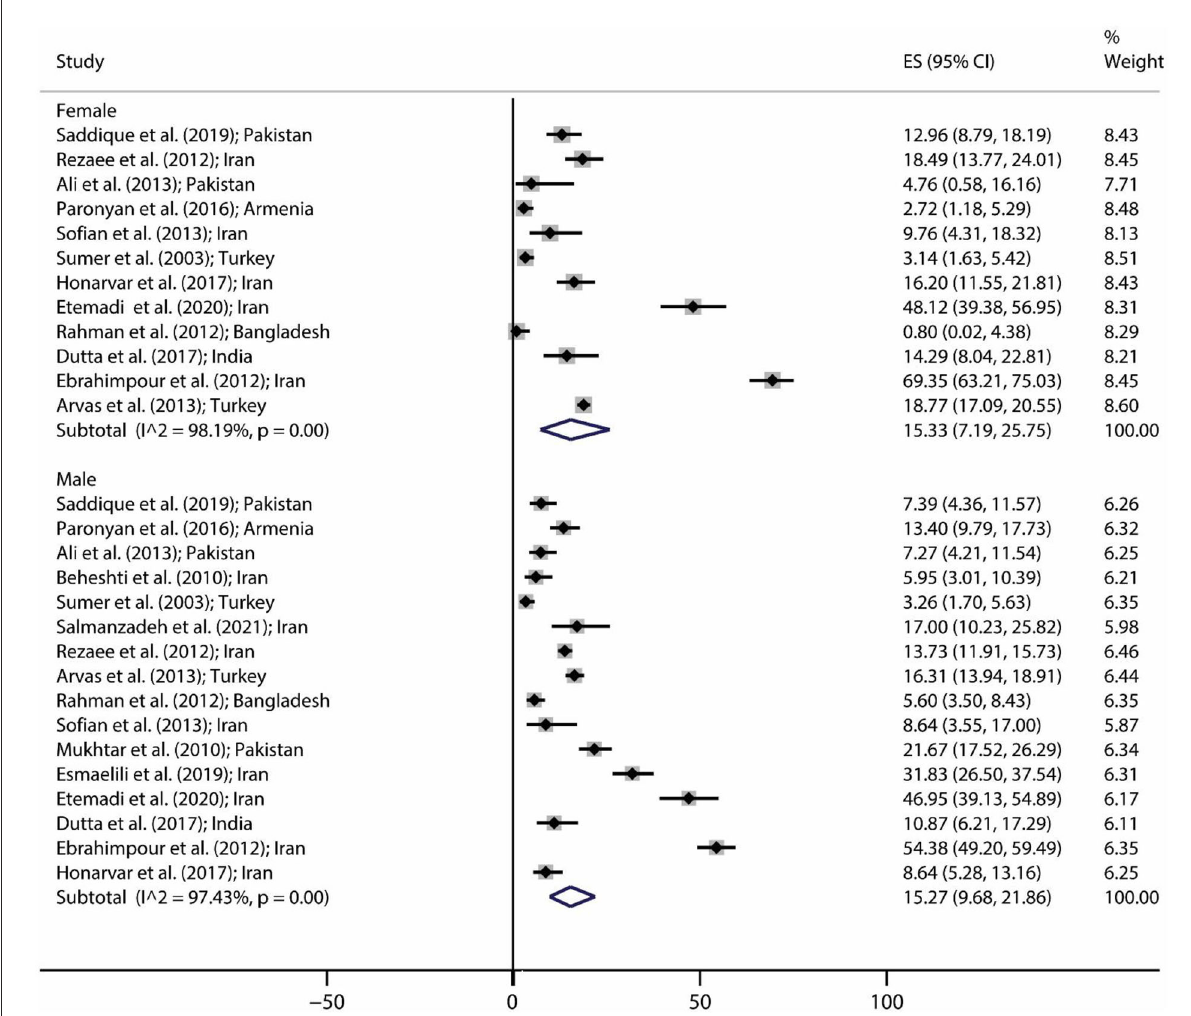
FIGURE3 Pooled prevalence with 95% confidence interval (CI) of brucellosis prevalence based on gender. The diamond mark shows the pooled prevalence, and the length of the diamond indicates the 95% CI.